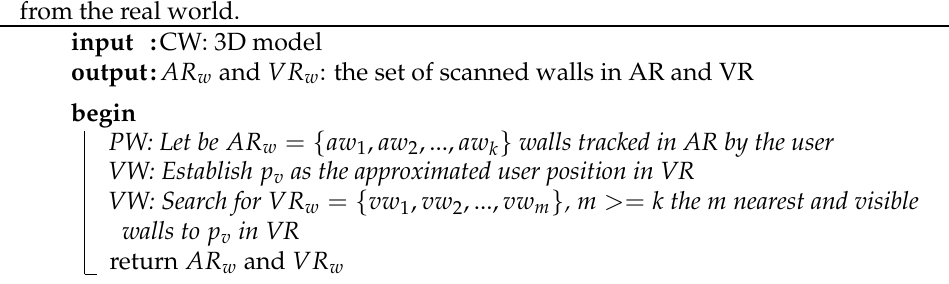
Algorithm 2: Extraction of virtual planes to be matched with scanned planes from the real